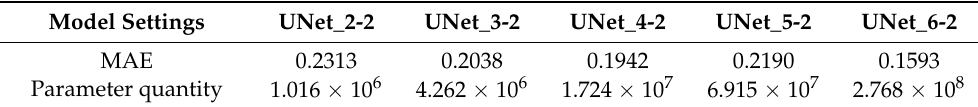
Table 2. Model performance comparison—number of downsampling components.